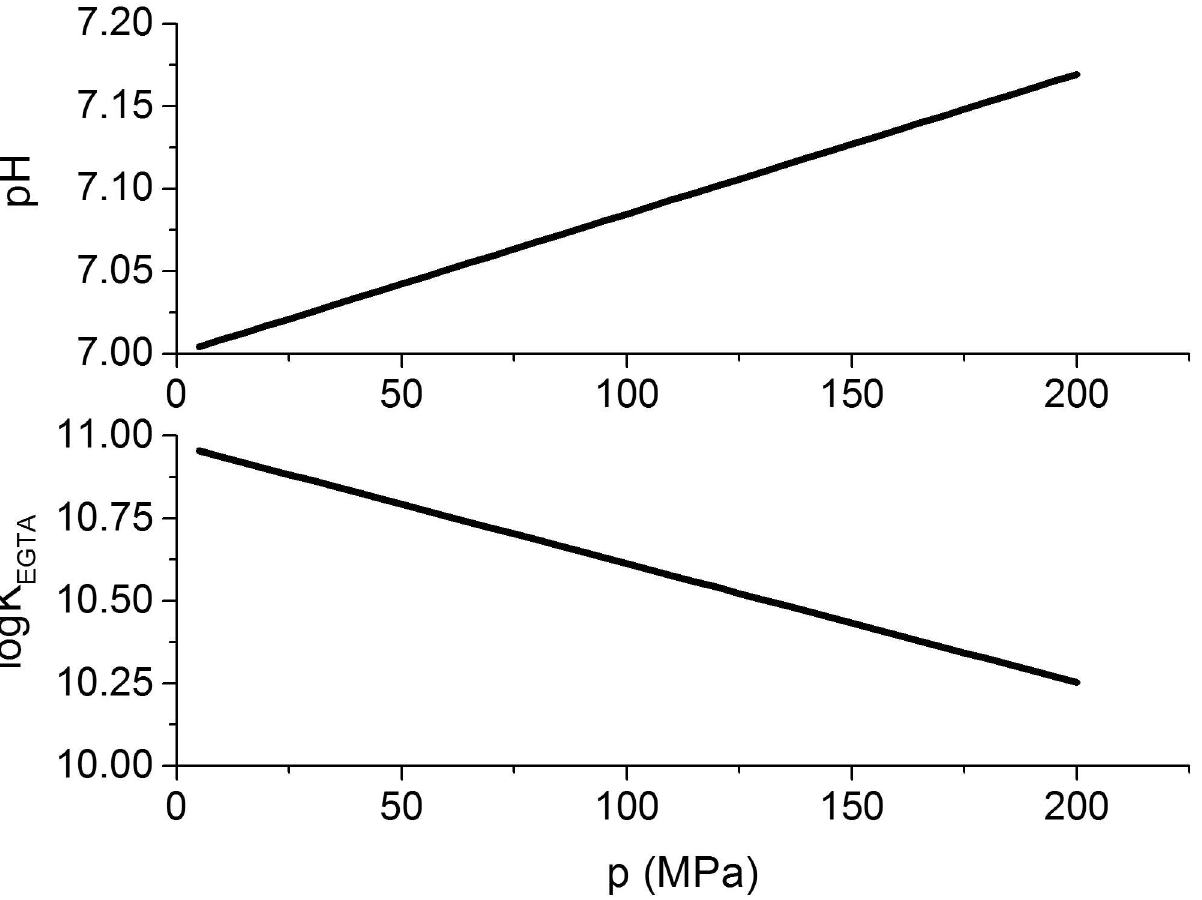
Fig 3. Pressure effects on pH and Ca 2+ -binding to EGTA. Pressure-dependence of pH due to pressure effects on HEPES accordingto Eq (14) [17] using the Δ i v determinedby Kitamura et al. [16]. The development of the equilibrium constant of EGTA bindingto Ca 2+ is estimated by Eq (16) using the Δ r v determinedby Hasselbachet al.